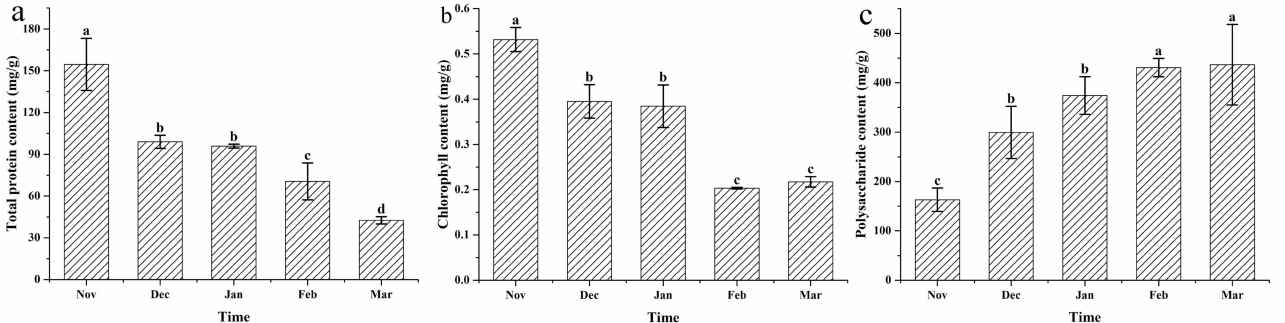
Figure 3. Quantity analysis of N. yezoensis samples at different harvest periods. ( a ) Total soluble protein content; ( b ) ChlorophyII content; ( c ) Cell wall hydrolyzed polysaccharides. Data were Mean ± SD ( n = 3). Different letters indicated significant differences ( p <